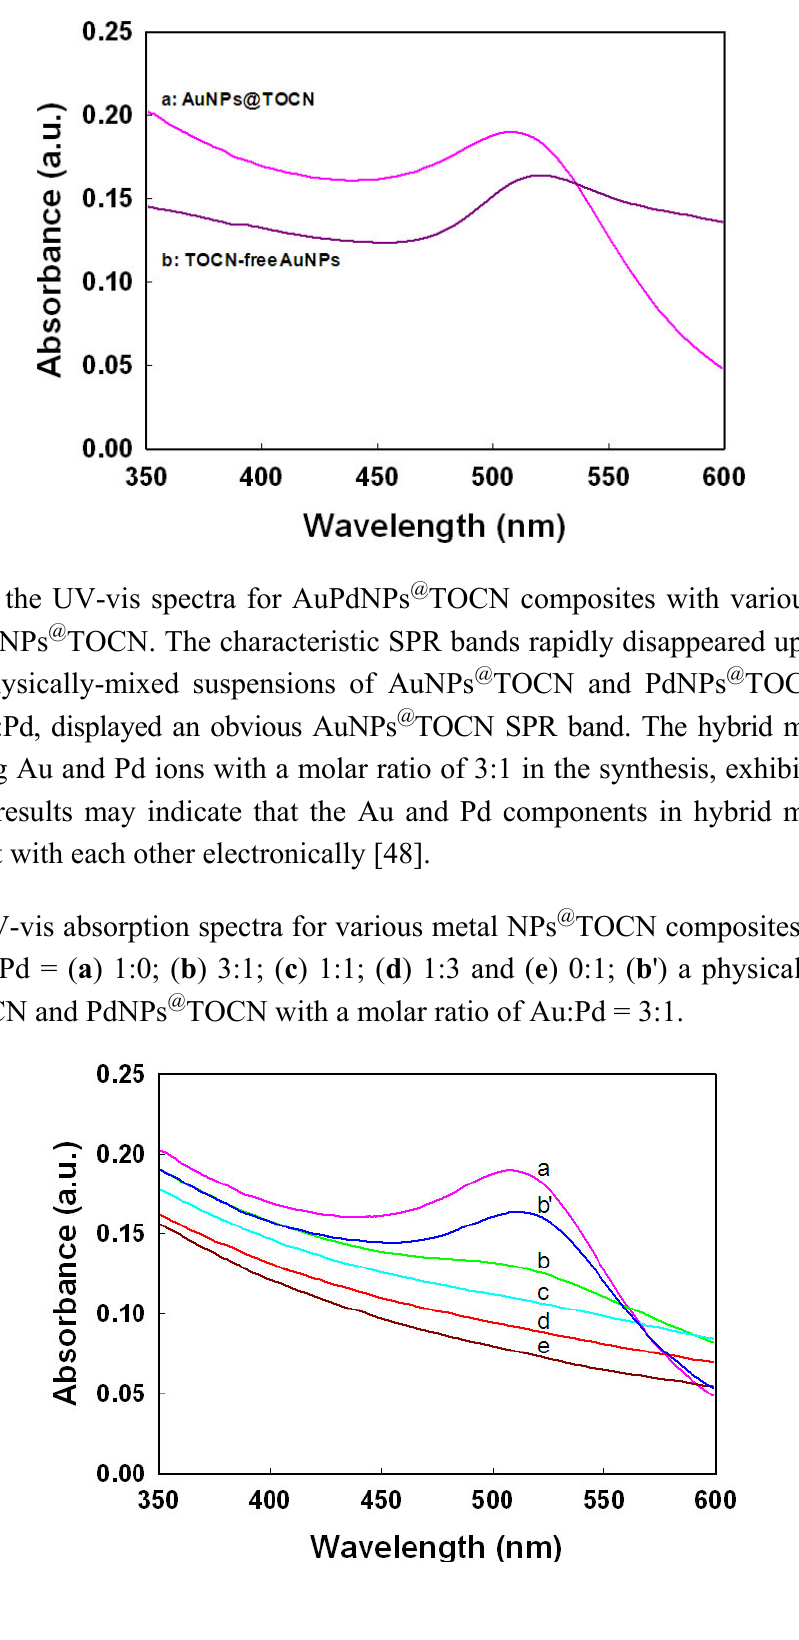
Figure 1. UV-vis absorption spectra of AuNPs in the presence ( a ) and absence ( b ) of TOCNs.